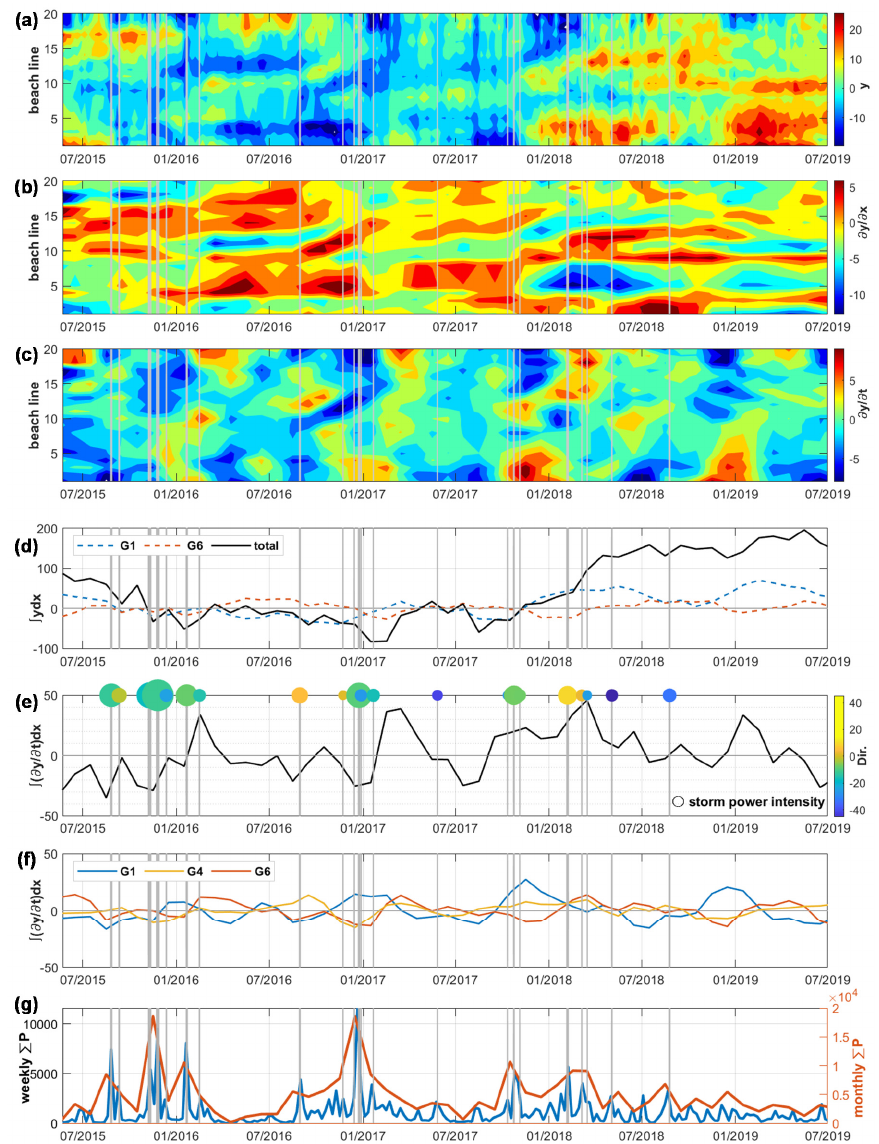
Figure 6. Temporal changes in ( a ) beach width 𝑦 and differentiated beach widths ( b ) ∂𝑦/ ∂𝑥 and ( c ) ∂𝑦/ ∂𝑡 . Time series of ( d ) integrated beach width ∫𝑦𝑑𝑥 along the total coast and sectors G1 and G6; ( e ) longshore transport rate ∫ 𝜕𝑦 𝜕𝑡⁄ 𝑑𝑥 with the storm power intensity circles colored by wave direction; ( f ) ∫ 𝜕𝑦 𝜕𝑡⁄ 𝑑𝑥 of some sectors (G1, G4, G6) and ( g ) weekly and monthly summed wave power. For the southern part of the beach (beachlines 1–5), 𝑦 rapidly decreased (i.e., the beach was